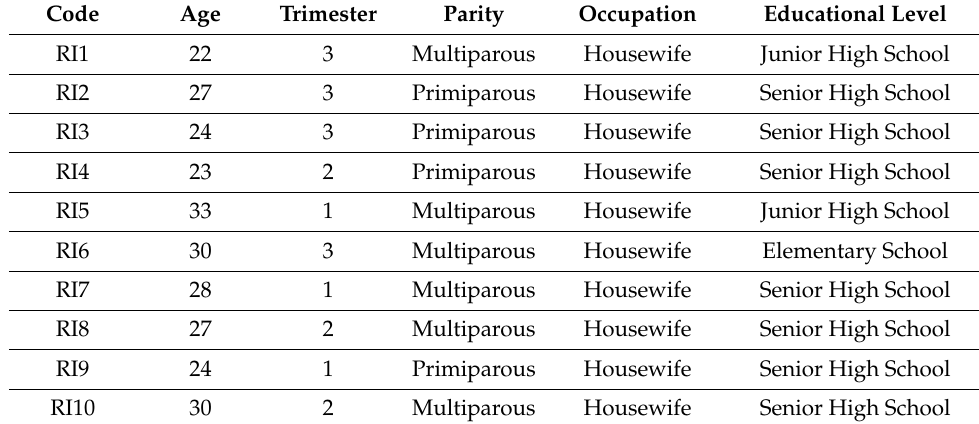
Table 1. Characteristics of Pregnant Women Respondents.